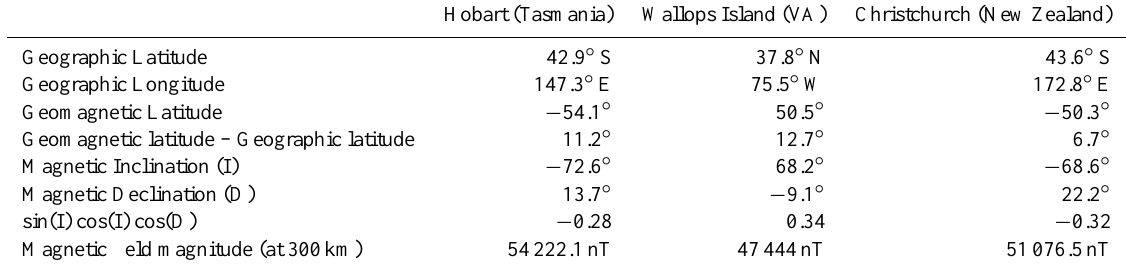
Table 1. Coordinates of the ionosonde stations at Wallops Island (VA), Hobart (Tasmania) and Christchurch (New Zealand). To account for secular changes in the geomagnetic field, the magnetic latitudes are the averages of years 1964 and 1976, calculated using the Defi- nite/International Geomagnetic Reference Field (DGRF/IGRF) model. See website